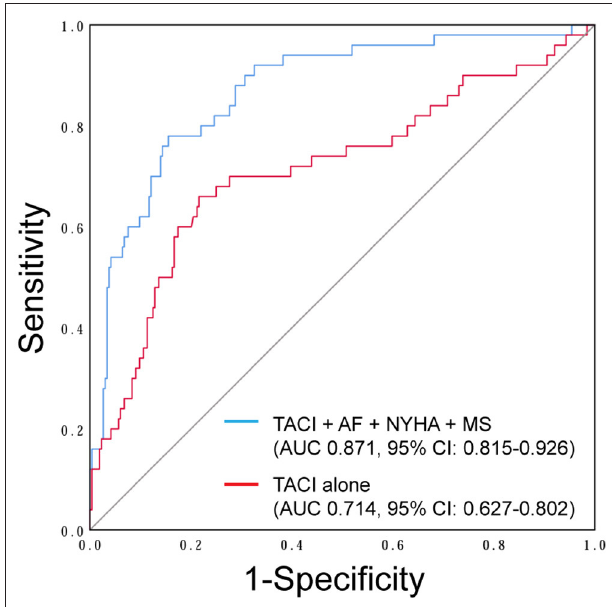
FIGURE 2 | Receiver-operator characteristic curve showing the tricuspid annulus circumference index (TACI) (red line) and combined multivariate analysis model (blue line) including the TACI, NYHA classification, preoperative atrial fibrillation (AF), and preoperative mitral stenosis (MS) as the independent predictors of preoperative severe functional tricuspid regurgitation (FTR).